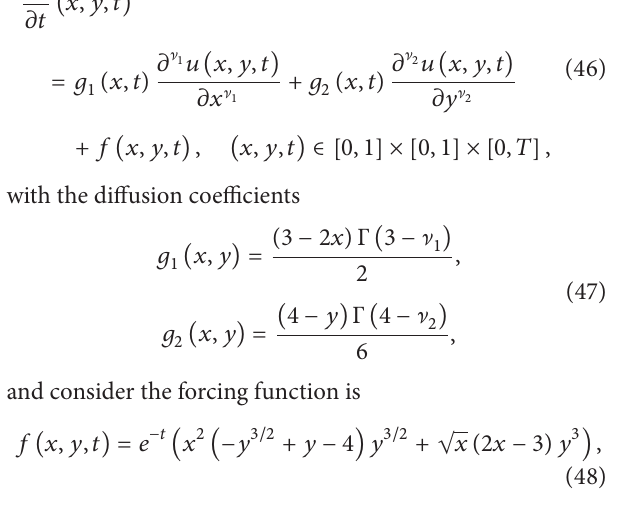
Figure 3: 𝑥 -direction curves of numerical and exact solutions of problem (40).